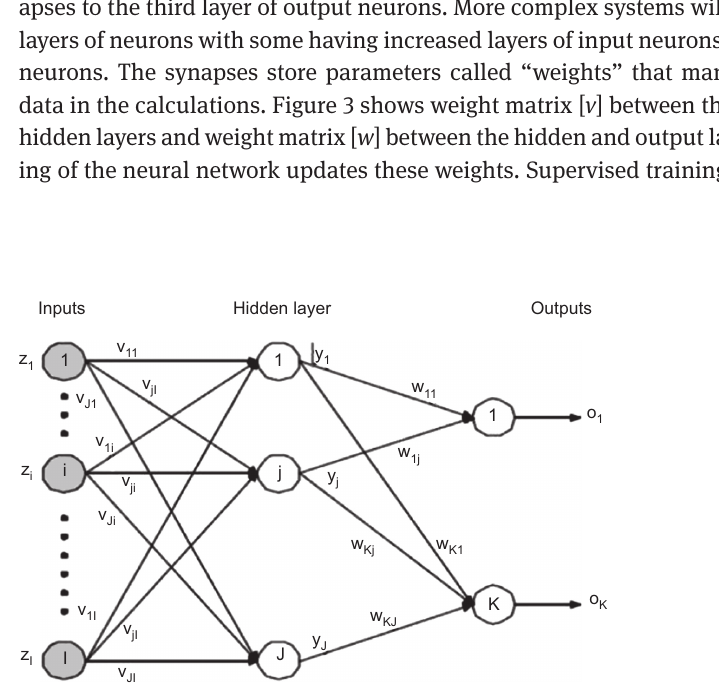
Figure 3. Neural Network Model with One Hidden